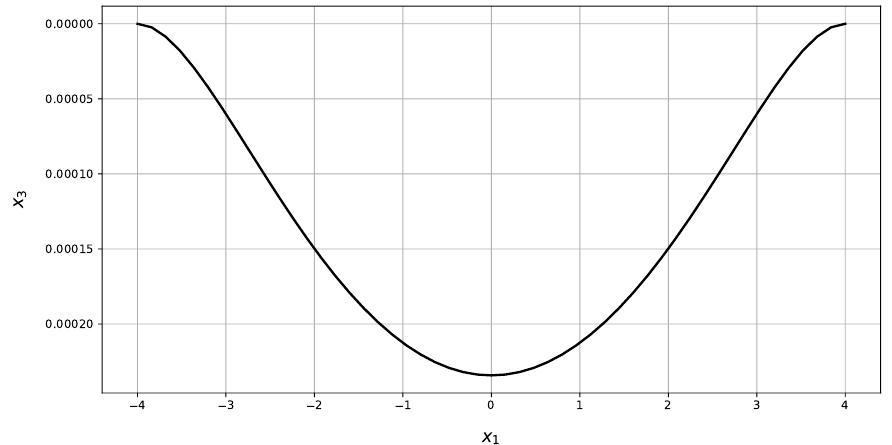
Figure 23. The deflection in section x 2 = 0 of a rectangular plate with clamped edges.